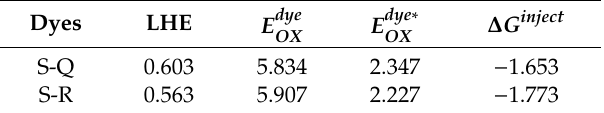
Table 6. The driving force of electron injection ∆ G inject (in eV) for S-Q and S-R. ∗ ∆ G inject Dyes LHE E dye E dye OX OX S-Q 0.603 5.834 2.347 − 1.653 S-R 0.563 5.907 2.227 −